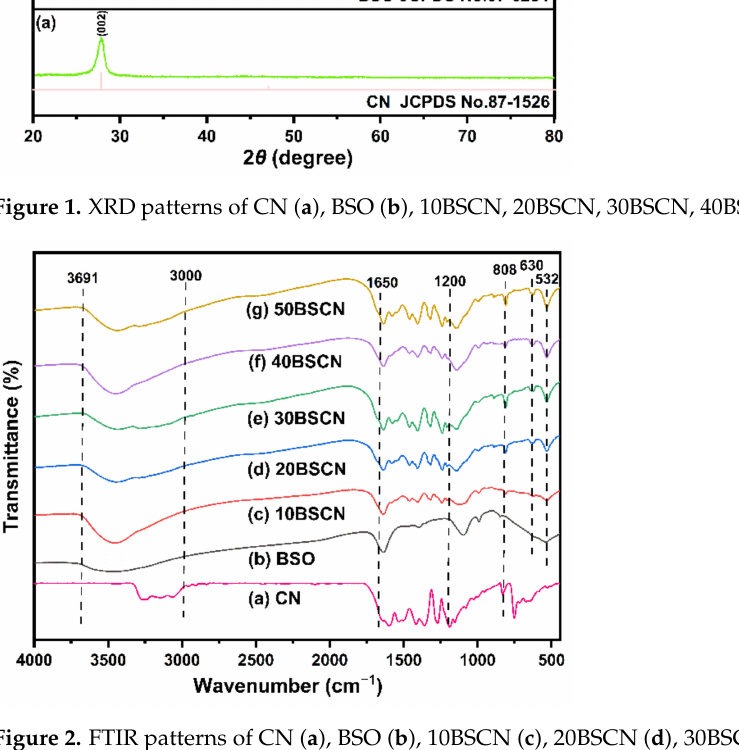
Figure 2. FTIR patterns of CN ( a ), BSO ( b ), 10BSCN ( c ), 20BSCN ( d ), 30BSCN ( e ), 40BSCN ( f ), and 50BSCN ( g